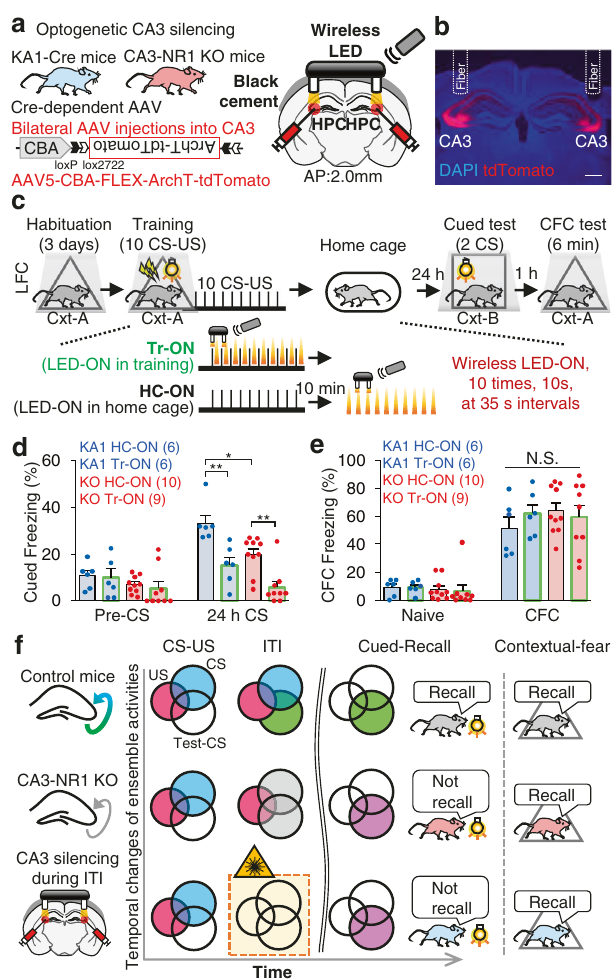
Fig.7| CA3-CA1pathwayactivity afterterminationofsensory stimuliiscrucial for cued-fear memory encoding but not for contextual fear memory. a Experimental design. b Coronal section of the hippocampus with tdTomato expressionand fi